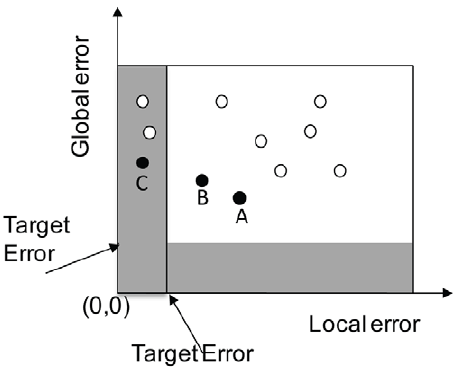
Figure6.Nodeselectionbalancinglocalandglobalerrorabsorption.